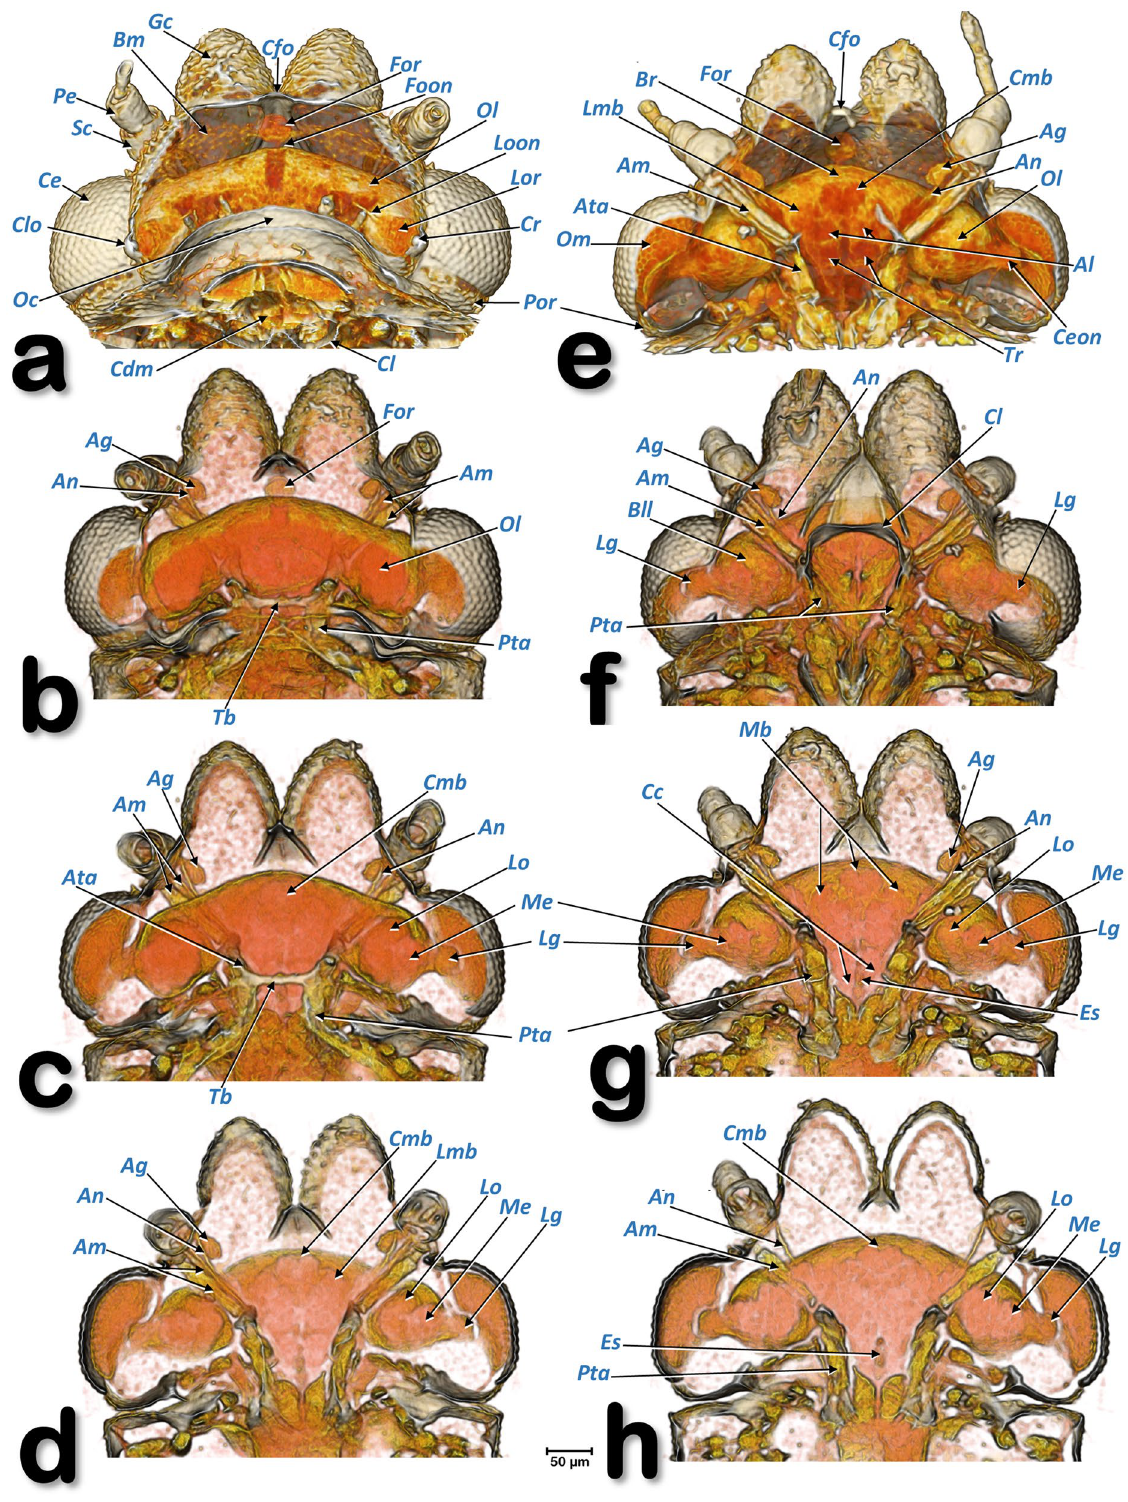
Figure 19. Volume-rendered images of the head of a female Diaphorina citri showing the brain and other internal structures. Dorsal views in the left-hand column ( a – d ) and ventral views in the right-hand column ( e – h ). From the top to the bottom successive dorsal/ventral cuts were made to obtain virtual slices. Abbreviations: Ag = antennal gland; Al = antennal lobe (deutocerebrum); Am = antennal muscles; An = antennal nerve; Ata = anterior tentorial arms; Bll = lateral lobe of brain; Bm = basal membrane; Br = brain (protocerebrum); Cc = circumesophageal connectives; Ce = compound eye; Cdm = cibarial dilator muscles; Ceon = compound eye optic nerve; Cl = clypeus; Cfo = cornea of the frontal ocellus; Clo = cornea of the lateral ocellus; Cmb = central mushroom body; Cr = crystalline lens; Es = esophagus; Foon = frontal ocellar optic nerve; For = frontal ocellar retina; Lg = lamina ganglionaris; Lmb = lateral mushroom body; Lo = lobulla; Loon =lateral ocellar optic nerve; Lor = lateral ocellar retina; Mb = mushroom bodies; Me = medulla; Oc = occiput; Ol = optic lobe; Om = ommatidia; Pe = pedicell; Pta = posterior tentorial arm; Sc = scapus; Tb = tentorial bridge; Tr =